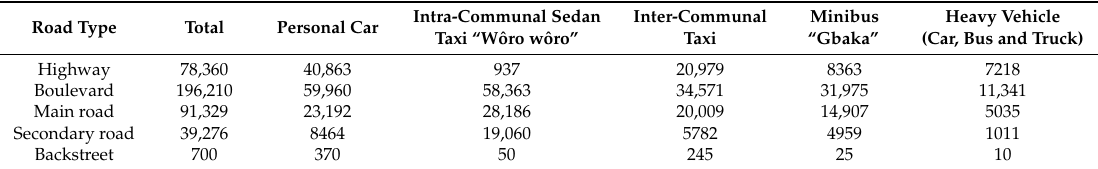
Table 2. Characterization of traffic flow total per class of road and type of vehicle (in bold is the contribution of vehicle type for each road